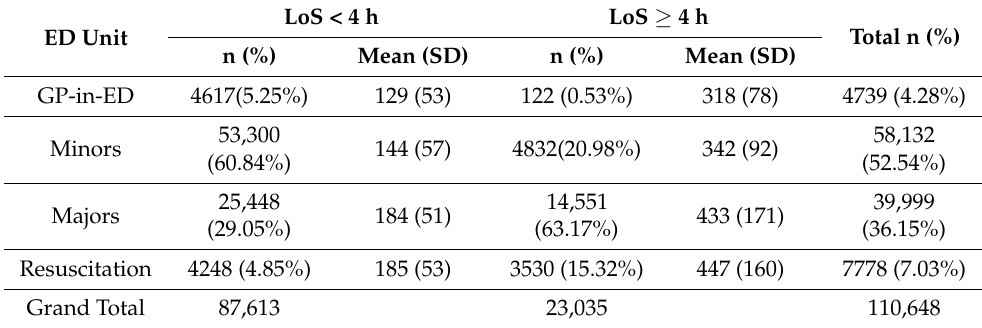
Table 2. Number of patients and length of stay per